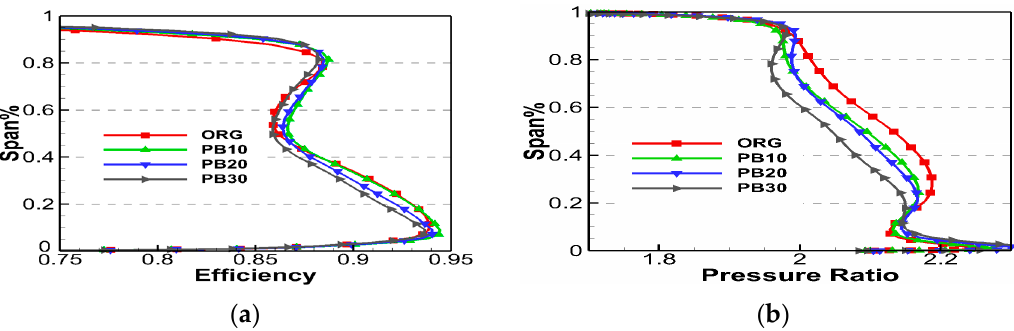
Figure 16. Comparison of efficiency and total pressure ratio spanwise distribution. ( a ) the isentropic efficiency. ( b ) the total pressure ratio.